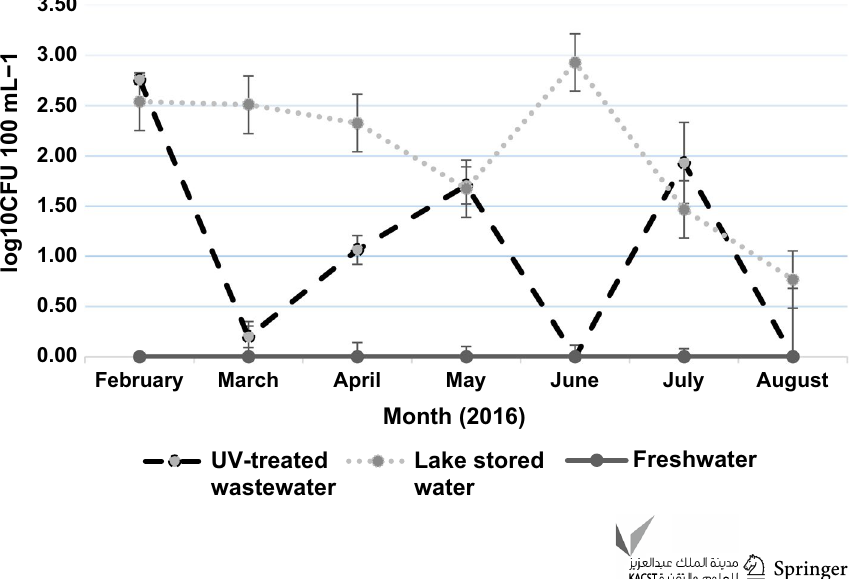
Fig. 5 Monthly variation of Faecal coliform in the irrigation water samples collected